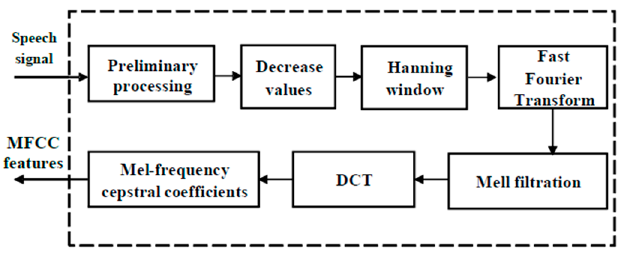
Figure 5. Classical scheme for calculating MFCCs.